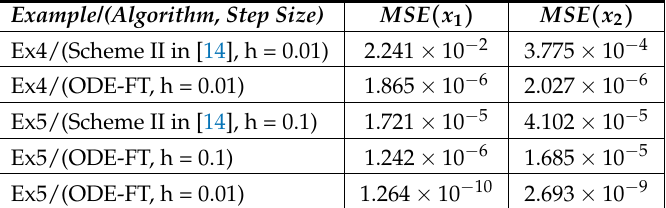
Table 6. For the two ODE problems in example Ex4 and Ex5, using different step-sizes, the table contains the computed MSE for the two solution-variables x 1 ( t ) and x 2 ( t ) , obtained by ODE-FT and Scheme II in